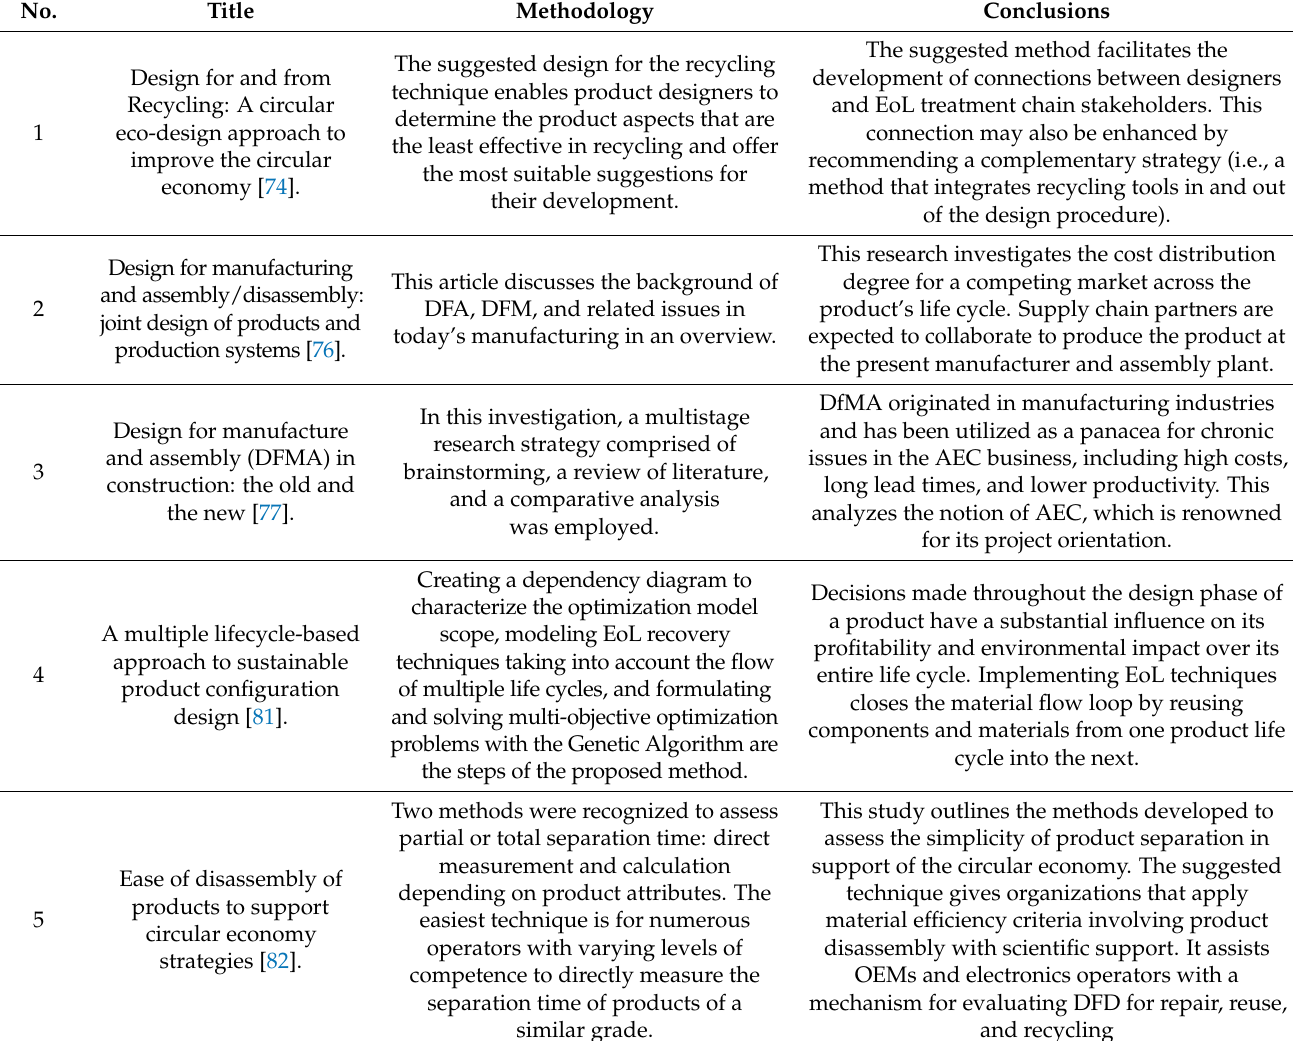
Table 1. The characteristics of the final selected and included articles for